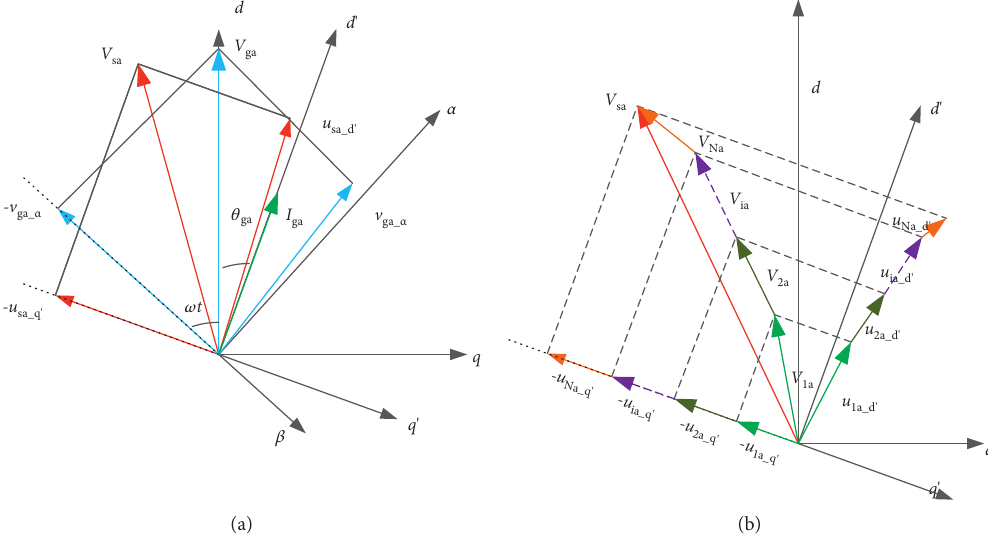
Figure 2: The relationship between the α-β coordinate system, the d-q coordinate system, and the d ′ - q ′ coordinate system. (a) The relationship between phase A grid voltage V ga , grid current I ga , and inverter output voltage V sa . (b) H-bridge inverter output voltage